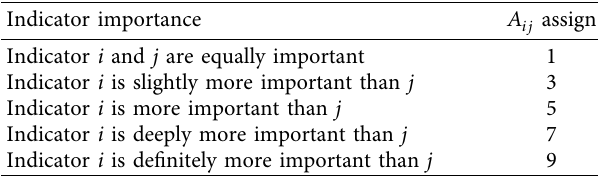
Table 3: Descriptive statistics of variables.